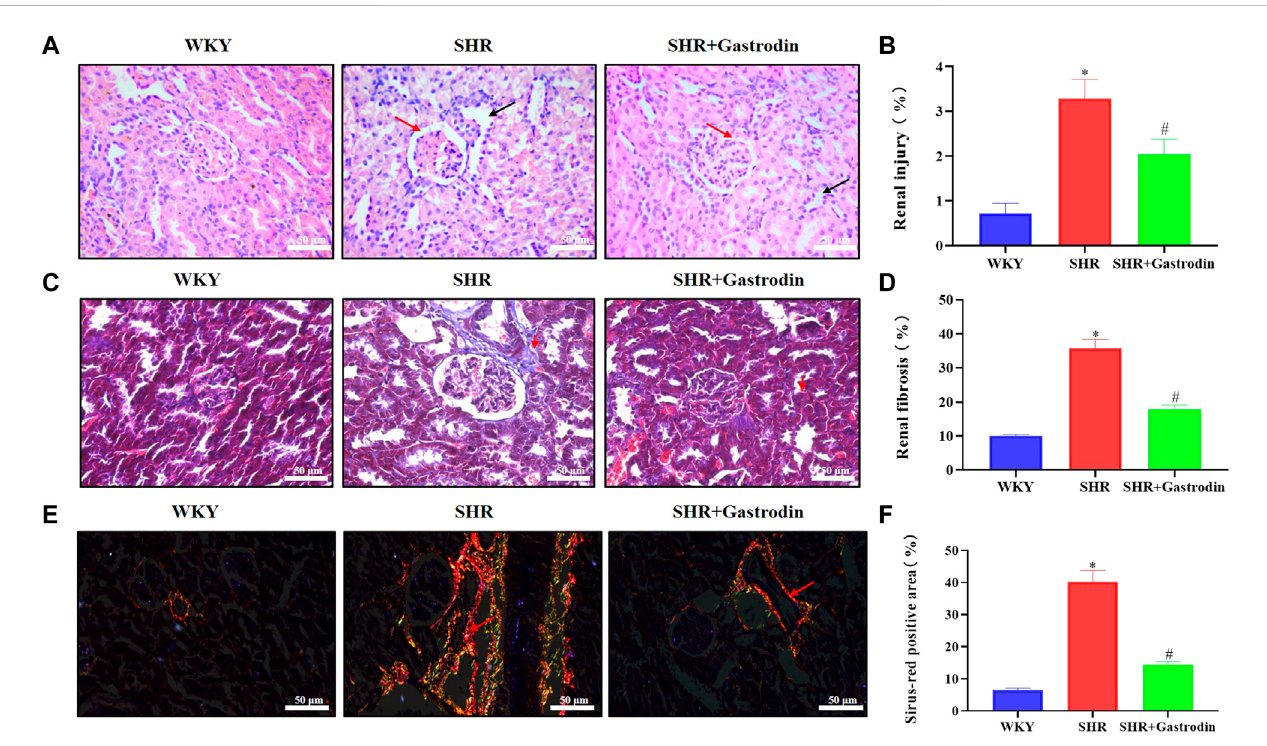
FIGURE 1 Gastrodinamelioratedhypertensiverenalinjuryandrenalinterstitial fi brosisinspontaneouslyhypertensiverats(SHRs) (A,B) Hematoxylinandeosin(H&E) staining was performed to determine the pathological changes in the renal tissues from each group. The representative images were taken at ×400 magni fi cation (scale bar 50 μ m). N = 5 for each group (C,D) Masson ’ s trichrome staining was performed to assess the degree of renal fi brosis in each group (E,F) Sirius red staining was performed to detect the accumulation of collagen fi bers in the renal tissue. All micrographs were taken at ×400 magni fi cation. Scale bar = 50 μ m. All values are mean ± standard deviation (SD) ( n = 5 for each group). * p < 0.05 vs the WKY group, # p < 0.05 vs the SHR